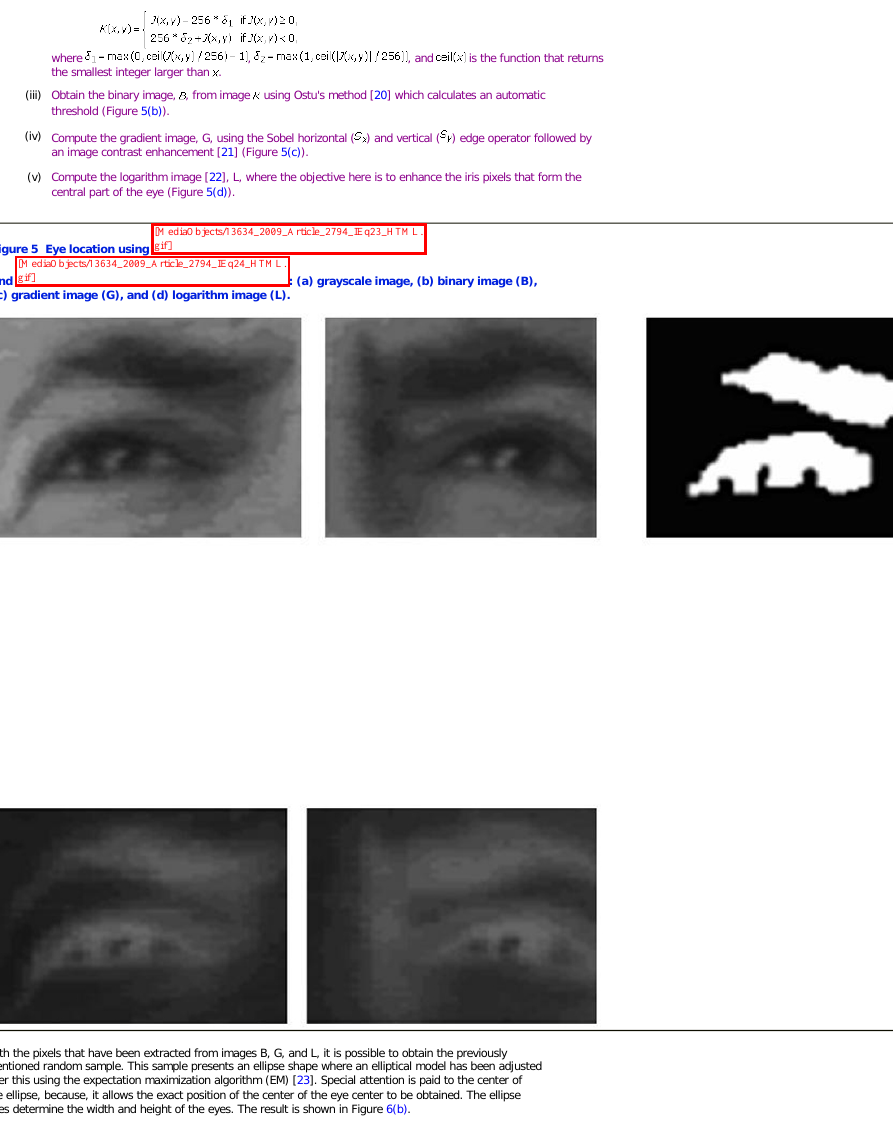
Figure 6 Expectation maximization algorithm over the spatial distribution of the eye pixels: (a) eye image, (b) ellipse parameters: center, axes, and inclination angle. (c), (d), (e), and (f) show other examples of this